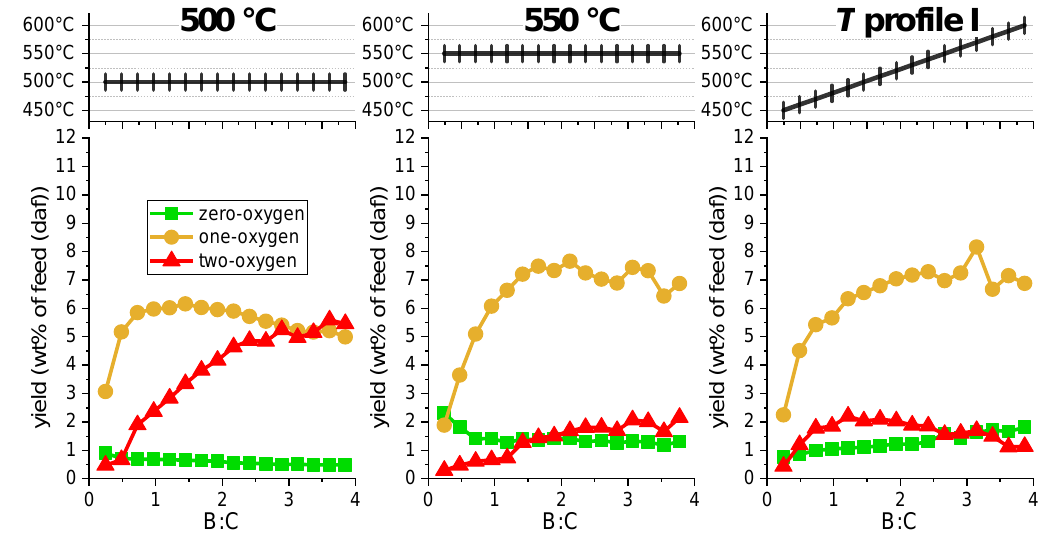
Figure 10. Yields (wt% of fed biomass (daf)) of hydrocarbons containing zero, one, and two or more oxygen atoms for upgrading over γ-Al 2 O 3 at constant temperatures of 500 and 550 °C or following temperature profile I. The momentary yields obtained at each biomass injection as a function of increasing cumulative B:C ratio are shown.